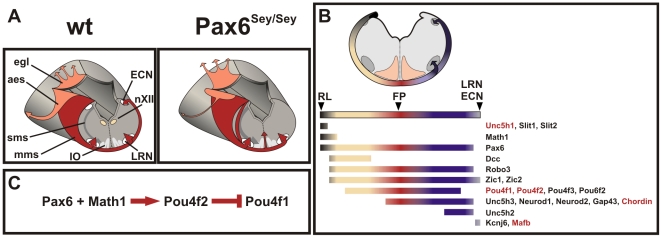
Summary of phenotypes observed in Pax6Sey/Sey RL derived neurons.(A) In Pax6Sey/Sey embryos the mms migration is delayed, some neurons migrate sub-marginally, neurons are arrested at the midline, the ECN is lost, the LRN is disrupted, and the IO is enlarged [16]. Additionally, the aes is reduced resulting in an absence of the pontine nuclei and granule cells of the cerebellum migrate ectopically into the inferior culliculus [14]. To search for genes expressed in mms neurons a large scale in situ hybridization screen was performed and a summary of the expression data of selected genes is shown in (B). The color code indicates expression of individual genes during migration of mms neurons: dark grey marks expression at the RL, beige before midline crossing, red during midline crossing, blue after crossing the midline and light grey marks expression during settlement in the ECN and LRN. Genes, which show altered expression levels in Pax6Sey/Sey embryos are marked in red. (C) A gene cascade in which Pax6 and Math1 positively regulate Pou4f2 expression leads to a repression of Pou4f1 expression. mms: marginal migration stream forming the external cuneate (ECN) and lateral reticular (LRN) nuclei; sms: sub-marginal migration stream forming the inferior olive (IO); aes: anterior extramural migration stream forming the pontine and pontine reticulotegmental nuclei; egl: external granule cell layer of the cerebellum; RL: rhombic lip; FP: floor plate.